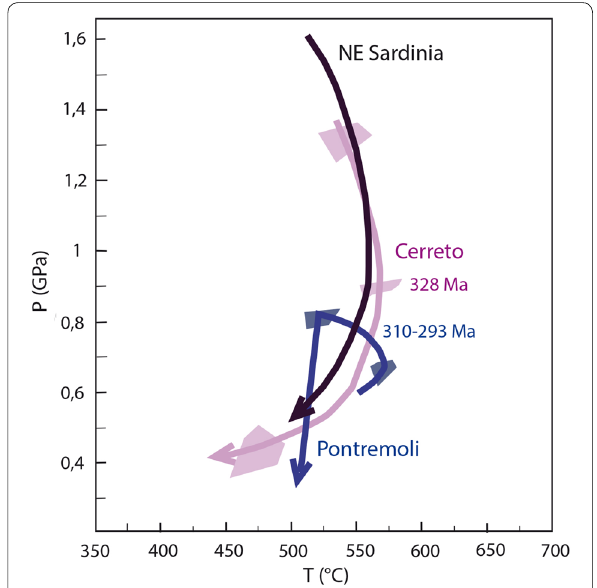
Fig. 4 P–T–t path for inner (pink line) and external (blue line) Tuscan basement compared with that proposed for the axial zone of the Sardinian Variscan belt (Cruciani et al. 2015) in black continuous line (after Lo Po’ et al.